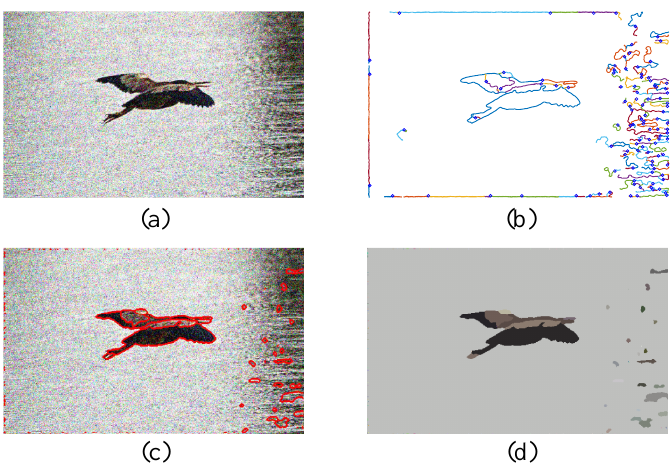
Figure 13. Noisy image segmentation results: ( a ) VOC2012 #2007_001289 image with SNR = 0 dB ( σ noise = 0.21), ( b ) particle trajectories obtained using PMLCD with a radius of LCD = 3, T | (cid:126) e | = 0.27,